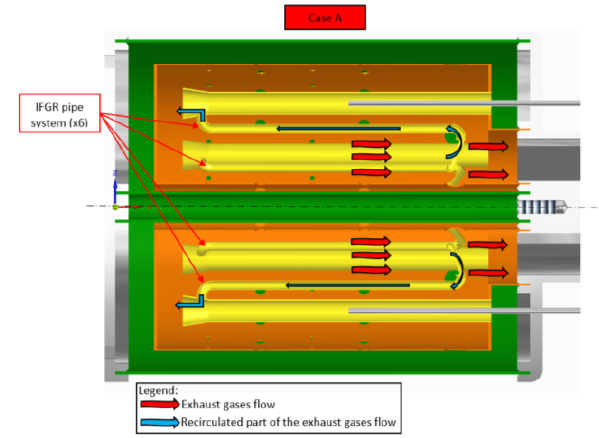
Fig. 3. Modified combustor (Case